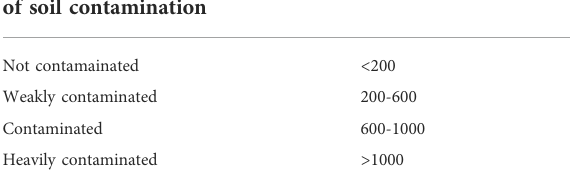
TABLE 3 Classi fi cation of soil contamination by